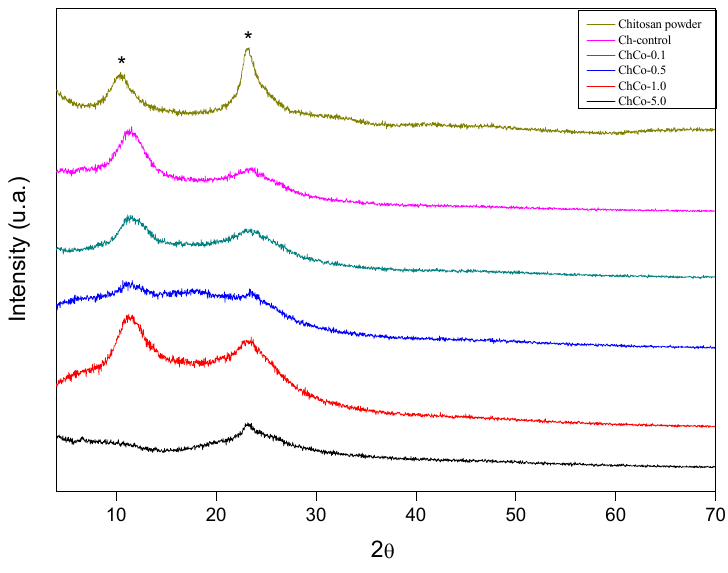
Figure 7. X-ray diffractogram. ( * ) Chitosan.